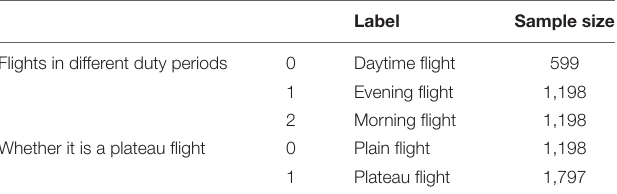
TABLE 7 | Multi-factor ANOVA between-subjects